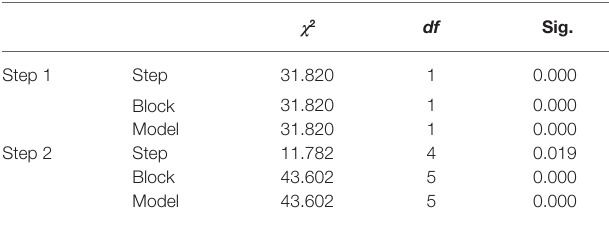
TABLE 8 | Omnibus tests for the workplace situation model